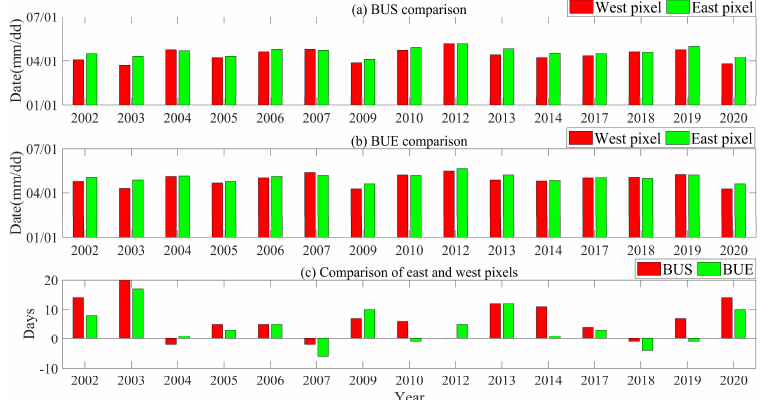
Figure 5. Comparison of break–up dates between east and west pixels in Nam Co during 2002 to 2021. ( a ) BUS in east and west pixels; ( b ) BUE in east and west pixels; ( c ) Difference of BUS and BUE between east and west pixels.